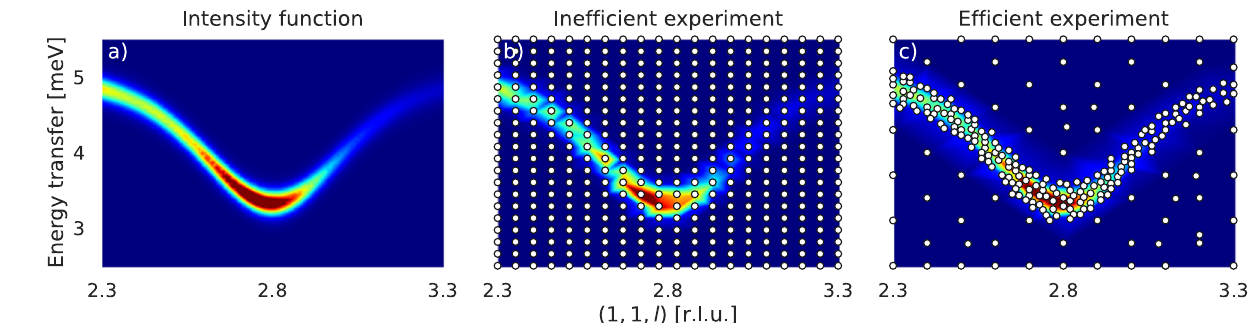
to red (high signal). b Inef fi cient experiment with a large part of measurement locations (dots) in the background (dark blue area). c More ef fi cient experiment with most measurement locations in the region of